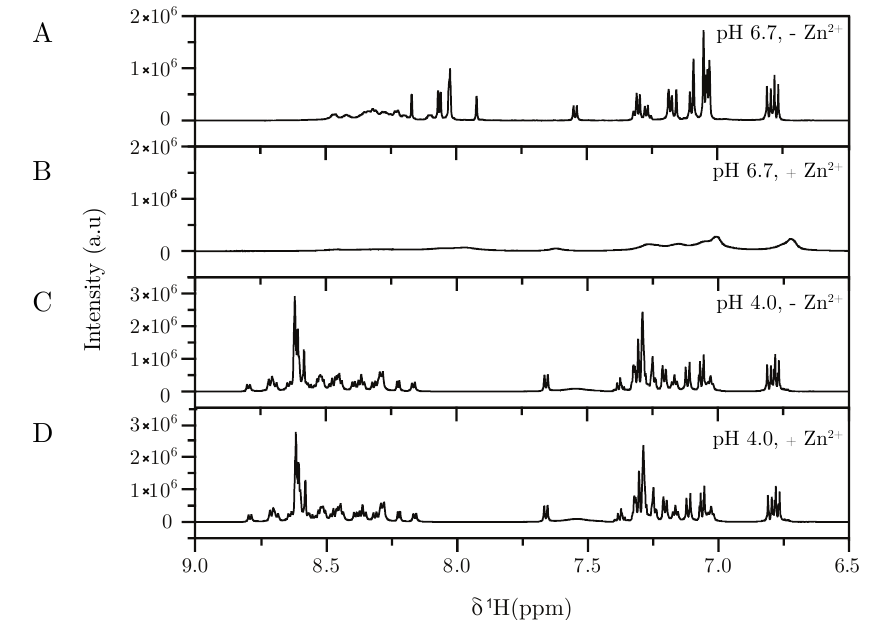
Figure 4. 1 H 1D NMR spectra of the aromatic region of Hst5 under different conditions . ( A ) pH 6.7, 150 mM NaCl, ( B ) pH 6.7, 150 mM NaCl, 4 mM ZnCl ( C ) pH 4.0, 150 mM NaCl and ( D ) pH 4.0, 2 150 mM NaCl, 4 mM ZnCl . All spectra were recorded at 20 ◦ 2